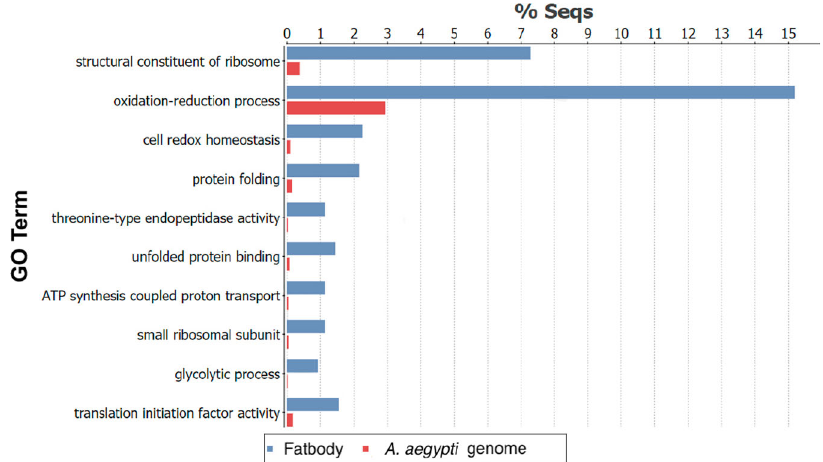
Fig. 4 Gene ontology analysis of Ae. aegypti fat body proteins. Bar chart showing over-represented GO terms present among detectable proteins in Ae. aegypti fat body 12 h after feeding on arti fi cial